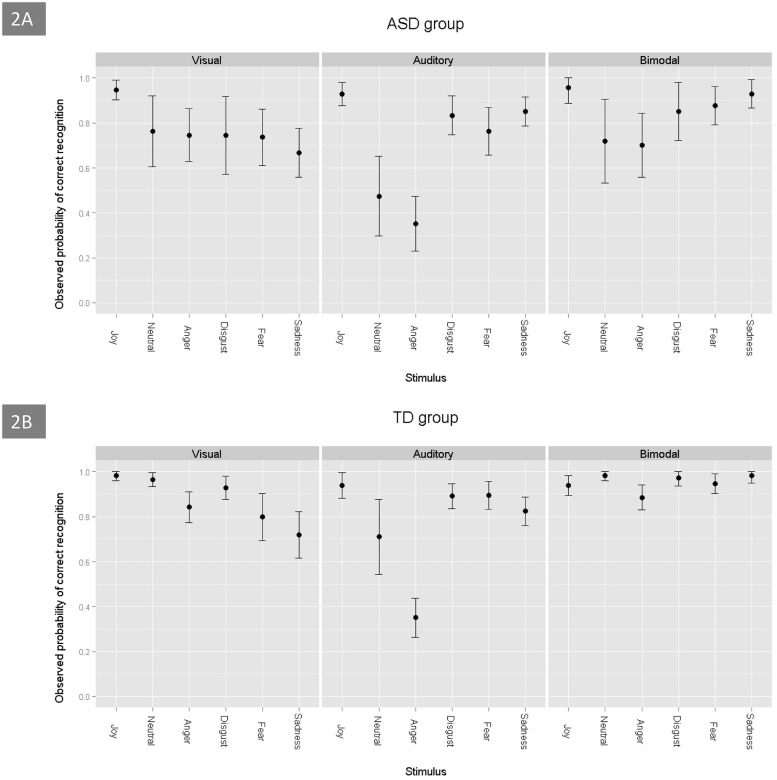
Probability of correct emotion recognition, as a function of the emotions and tasks, in ASD (A) and TD (B) children.